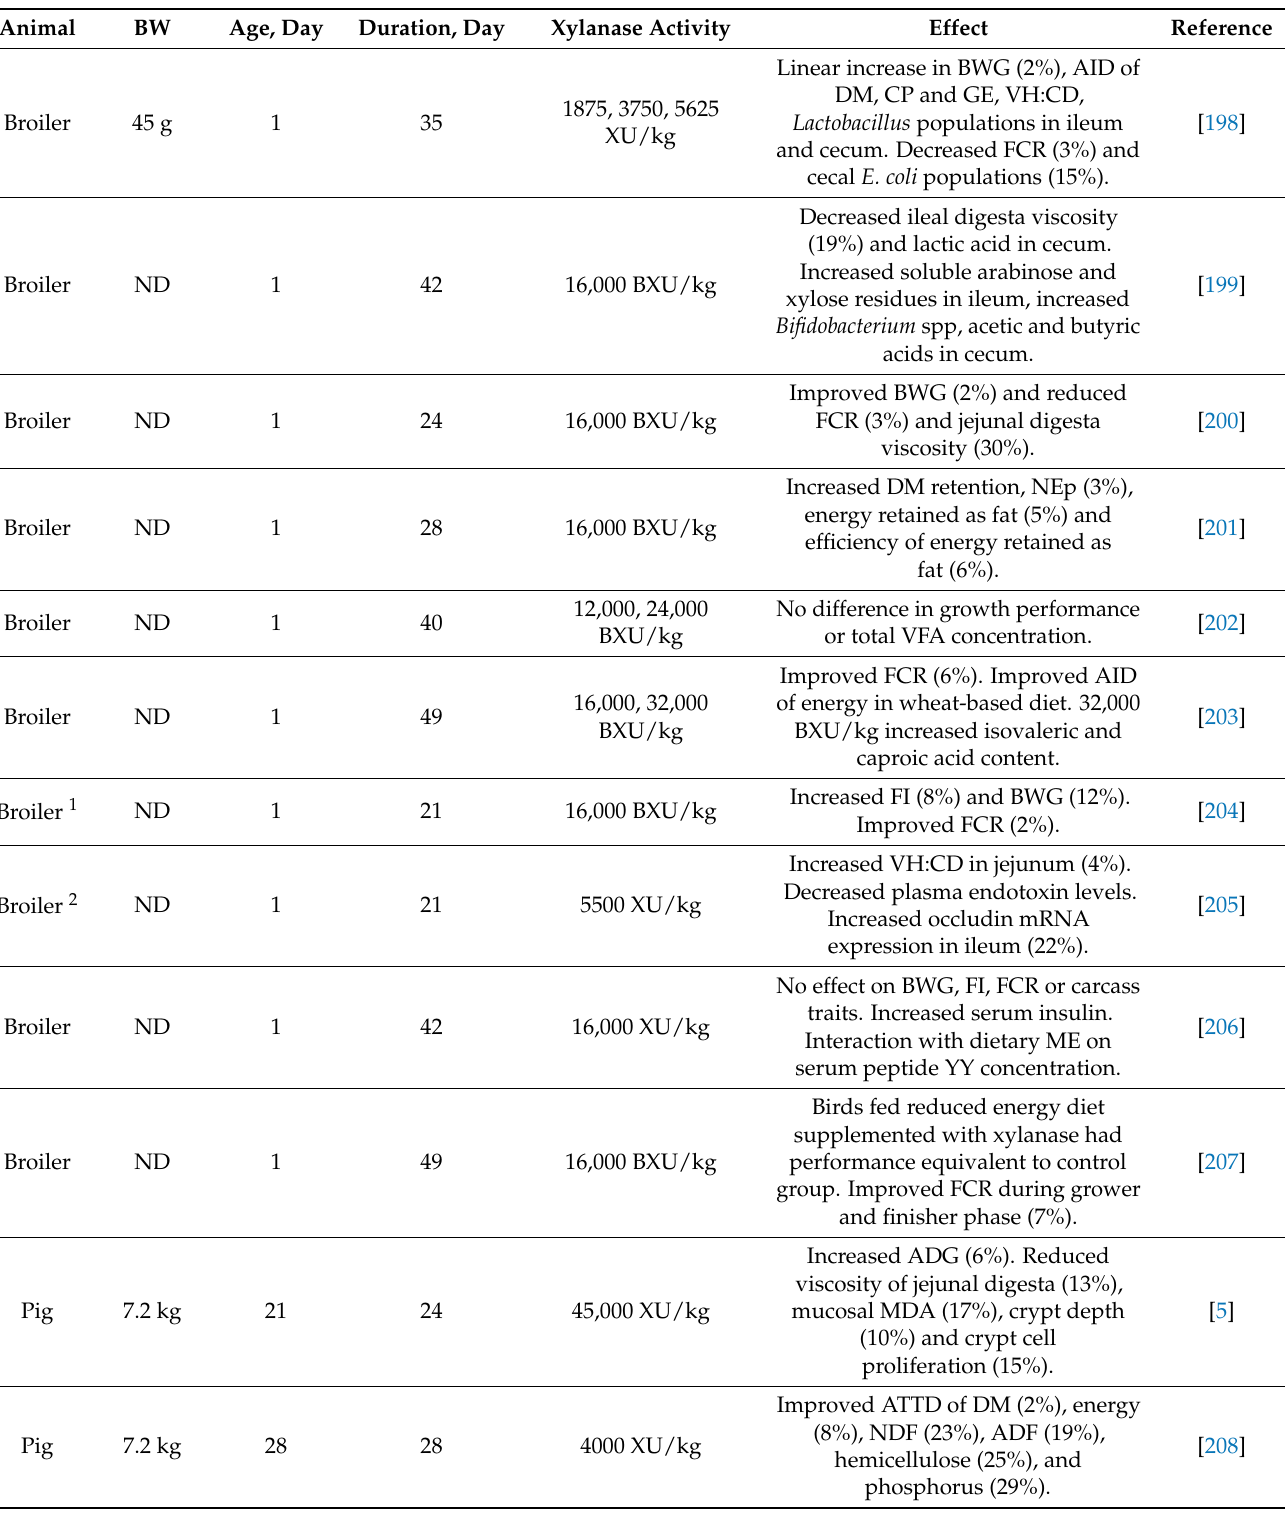
Table 4. Effects of xylanase supplementation in swine and poultry